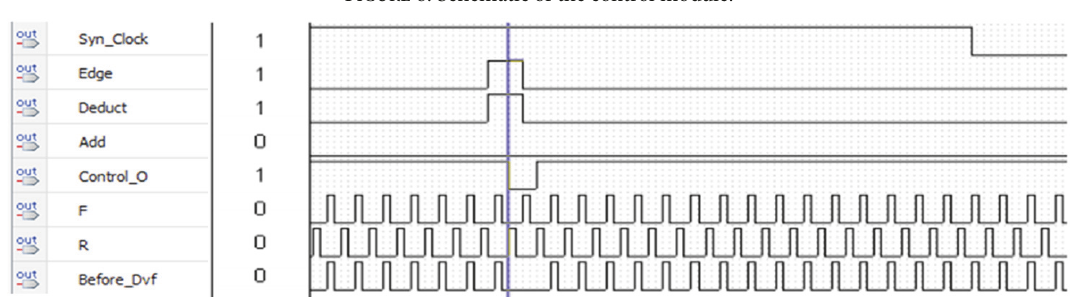
Figure 9: Simulation result of control module in phase